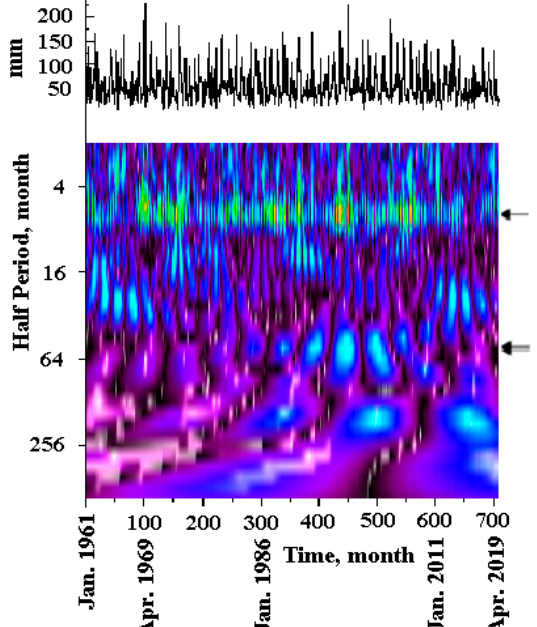
Figure 12. Wavelet-periodogram of long-term (1961–2019) observations of precipitation (monthly amount, mm) at the Khmilnyk weather station. Cyclicity periods: top arrow—1 year, lower arrow—8 years.